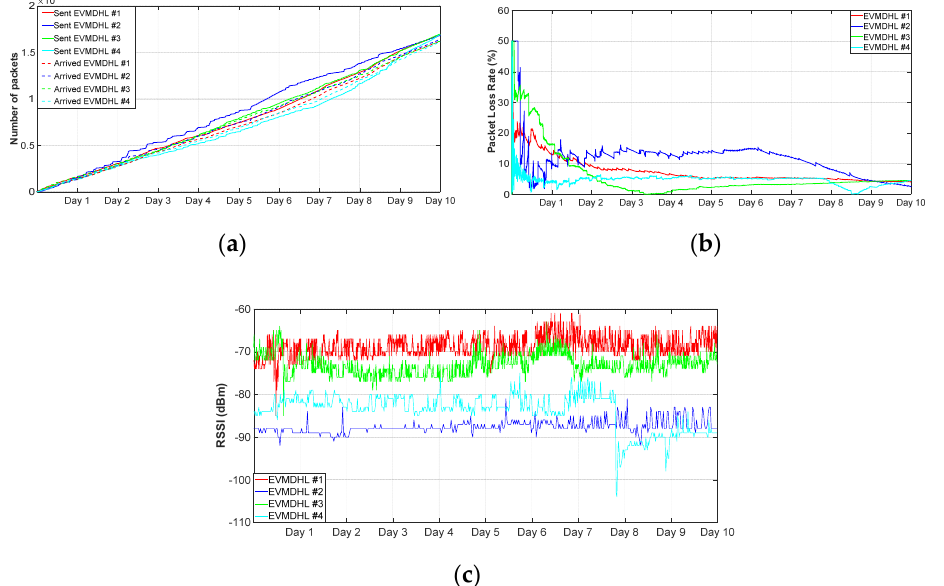
Figure 17. LoRa network measurements: ( a ) packets sent and received, ( b ) packet loss rate (PLR) and ( c ) RSSI. As for the Received Signal Strength Indicator (RSSI), the analysed EVMDHLs are − 68.8131 and − 83.9871 dBm for EVMDHL #1 and #4, respectively. Moreover, the standard deviations are 2.4463 and 4.0688 for EVMDHL #3 and #4,